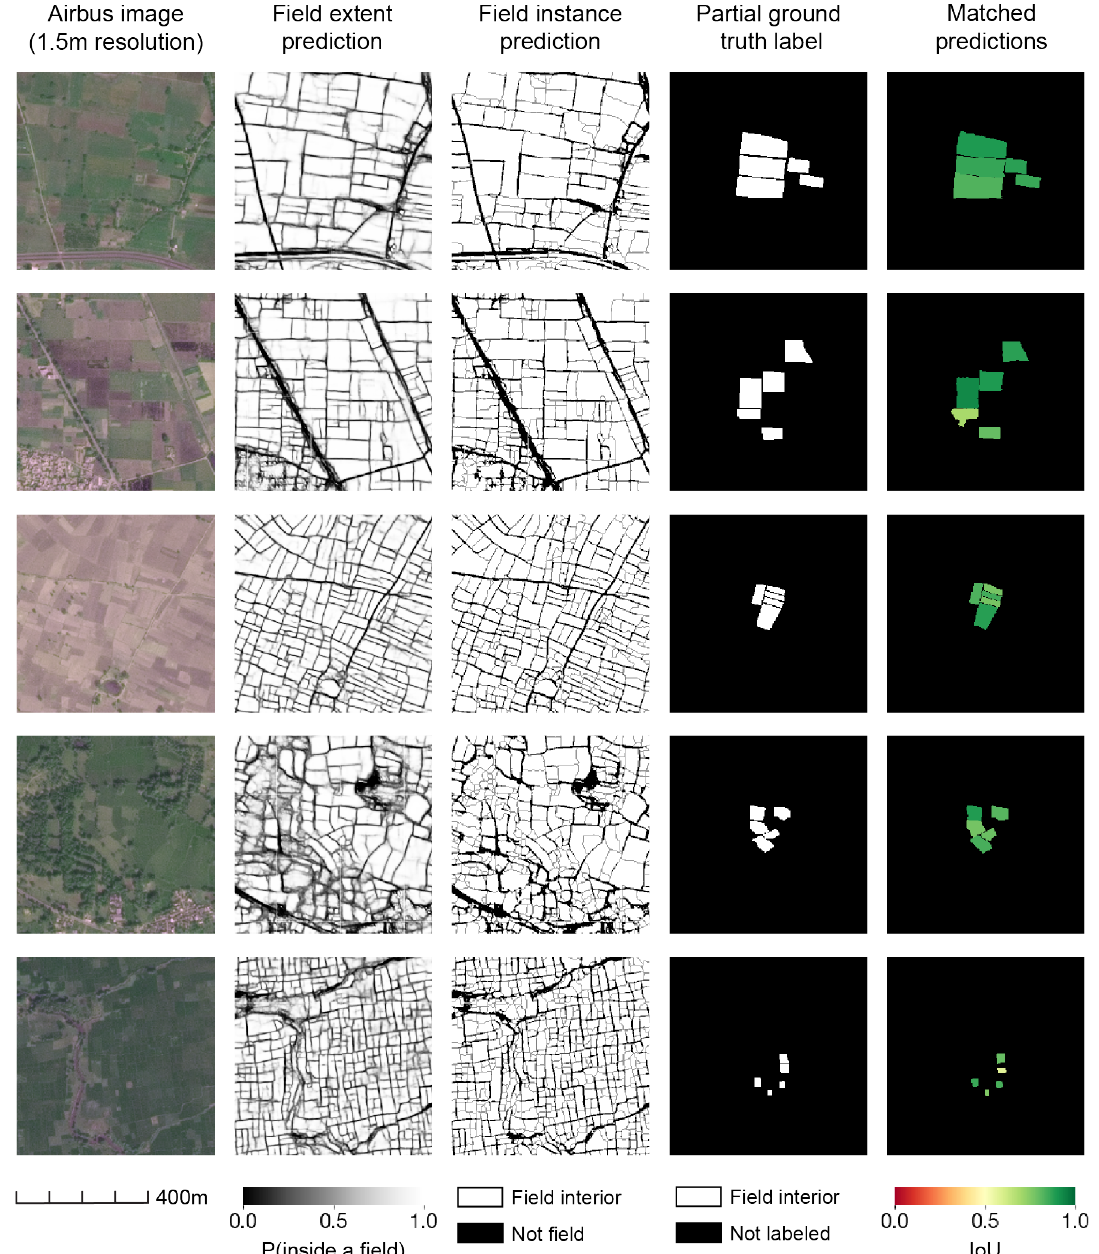
Figure 9. Examples of using Airbus SPOT to delineate fields in India. ( Left to right ) Airbus SPOT images in India and their corresponding field extent predictions, full field instance predictions, ground truth labels (5 fields each), and field instance predictions matched to the 5 labeled fields. For each matched field prediction, the color of the field corresponds to the IoU of the ground truth label with the predicted